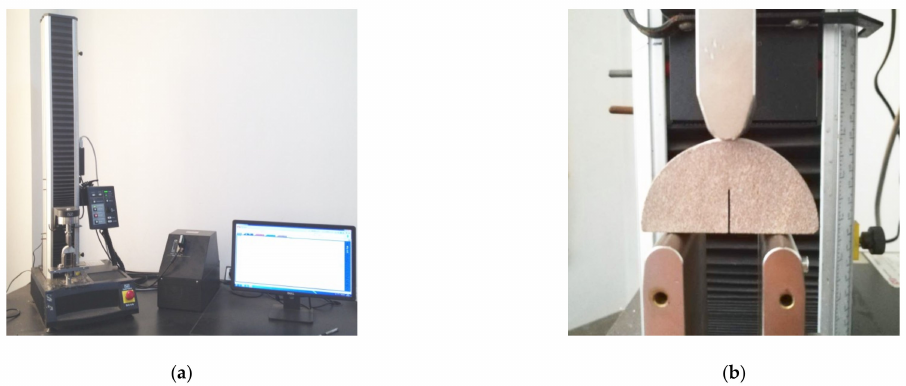
Figure 3. Experimental set-up for SCB tests. ( a ) Loading system; ( b ) Loading configuration.